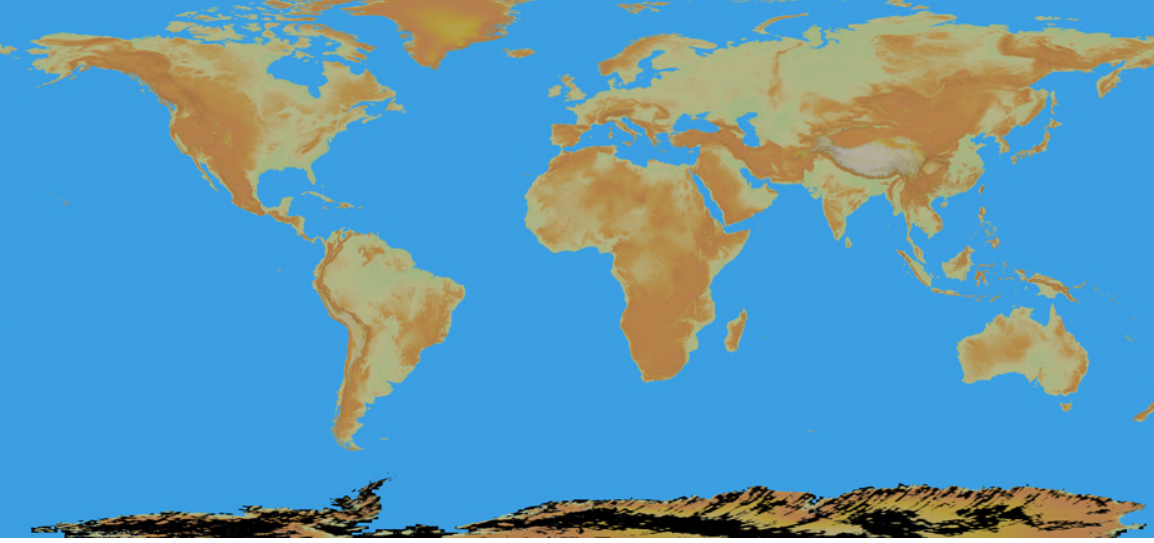
Figure 9. Global coverage of the AW3D30 void-filled version 3.1.